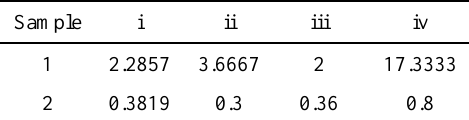
Table 3. The new sample’s relative distance to the best-practice frontier Sample